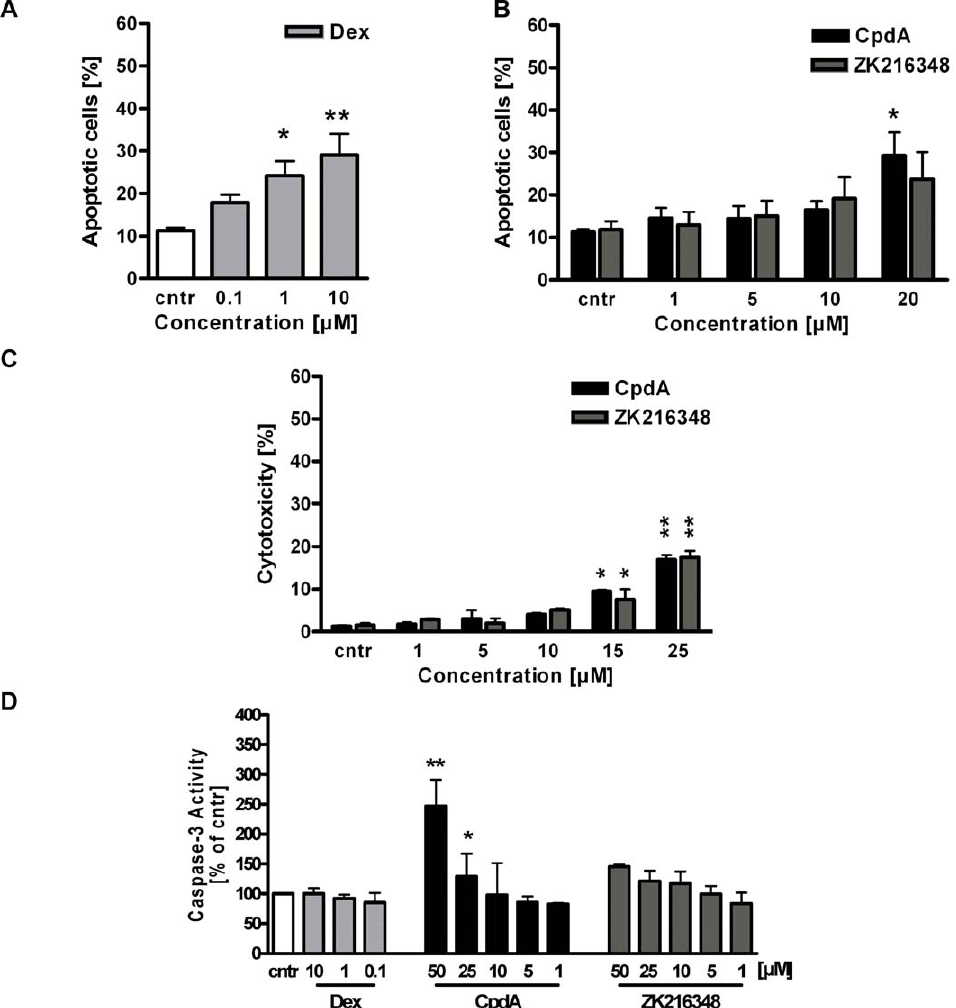
Figure 3. Effect of SEGRAs on cell apoptosis. Apoptotic effects of ( A ) Dex- [0.1–10 m M] or ( B ) CpdA- and ZK216348- [1–20 m M] treatment on IEC- 6 cells was evaluated after 24 h by Annexin-/7-AAD staining and flow cytometric analysis. ( C ) Cytotoxicity of CpdA or ZK216348 [1–25 m M] treatment on Caco-2 cells was tested by Cytotoxicity Detection (LDH release) kit. Bars indicate mean 6 S.E.M., n=3, * P # 0.05, ** P # 0.01, *** P # 0.001 relative to vehicle. ( D ) Activation of Caspase-3 in Caco-2 cells after 24 h of incubation with Dex, CpdA and ZK216348 [1–25 m M]. Results are expressed as a percentage of control. Bars indicate mean 6 S.E.M., n=3, * P # 0.05, ** P # 0.01, *** P # 0.001 relative to vehicle.